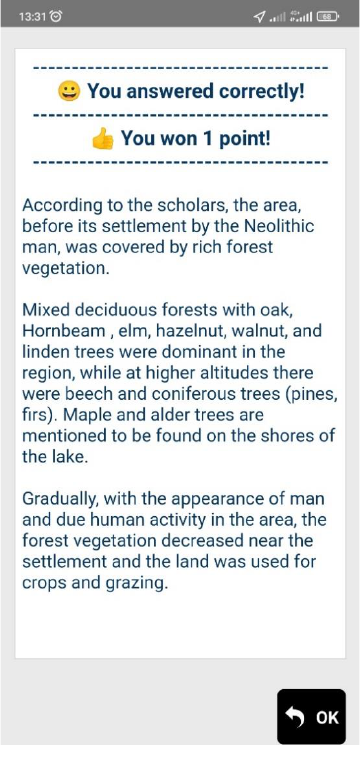
Figure 8. Feedback given to the users after they answer question 3.